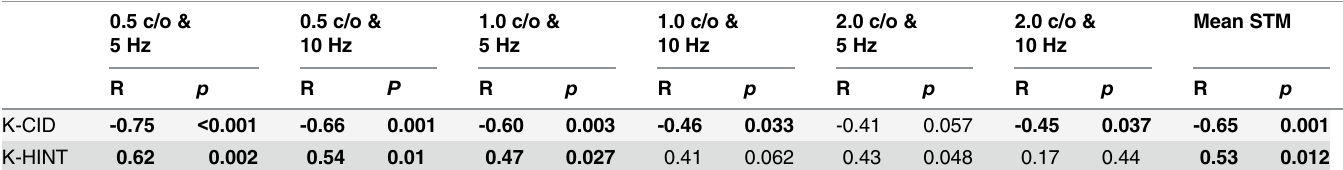
Table 6. Results for partial correlations analyses. Underlined italics indicate the correlations that were originally significant shown in Table 4 but became non-significant after controlling for predictive effect of temporal modulation detection. Partial correlations between STM detection test measures and sentence recognition in quiet (K-CID) and in noise (K-HINT) while controlling for predictive effect of temporal modulation detection. 0.5 c/o & 5